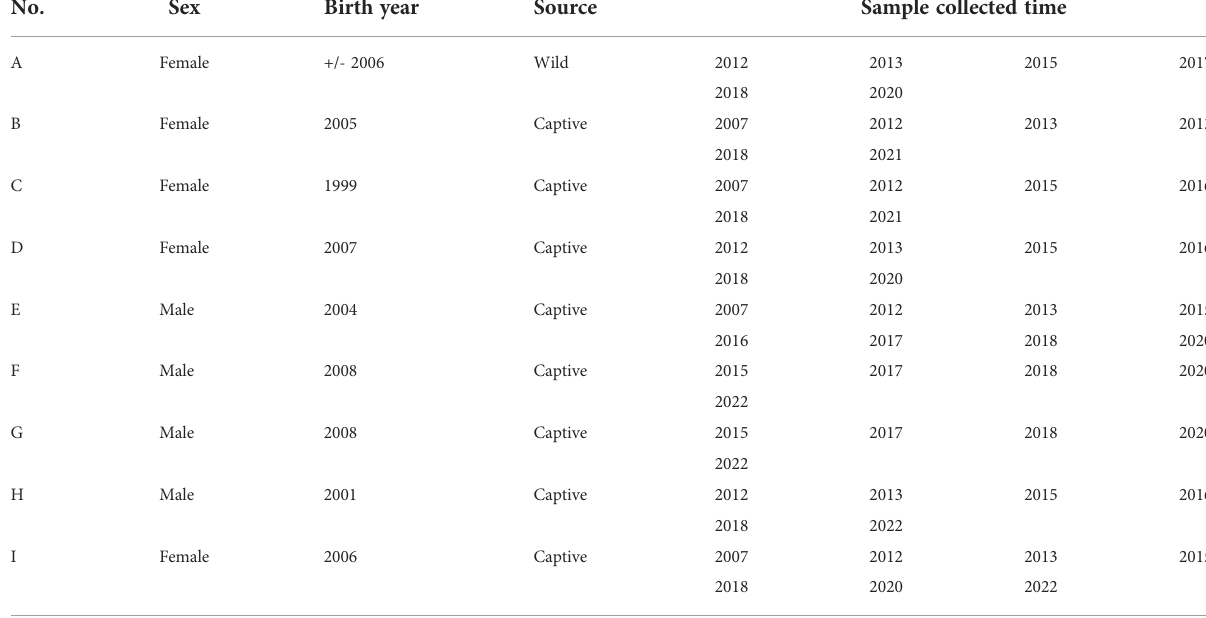
TABLE 1 The summary information of the subset of nine adult giant pandas and the number of samples by year.